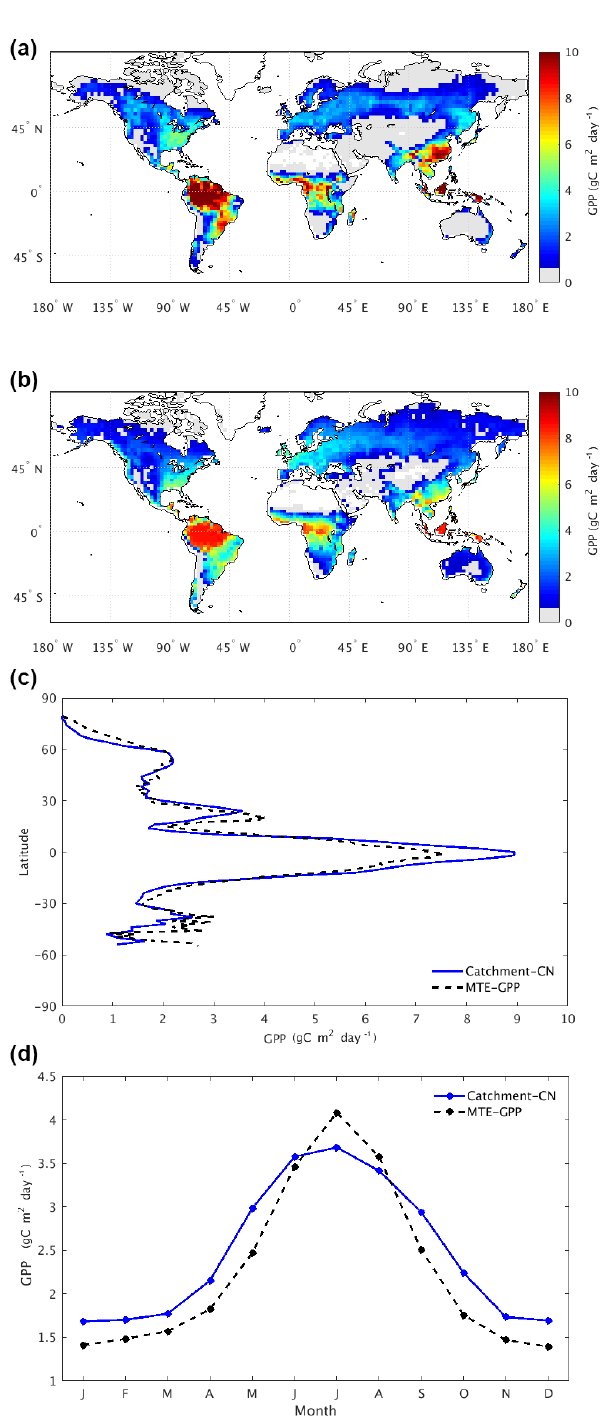
Figure 2. Spatial patterns of 2002–2011 mean GPP (gCm − 2 day − 1 ) from (a) Catchment-CN GPP and (b) MTE- GPP as well as (c) zonal mean GPP and (d) the annual cycle of GPP (solid blue: Catchment-CN model; dotted black: